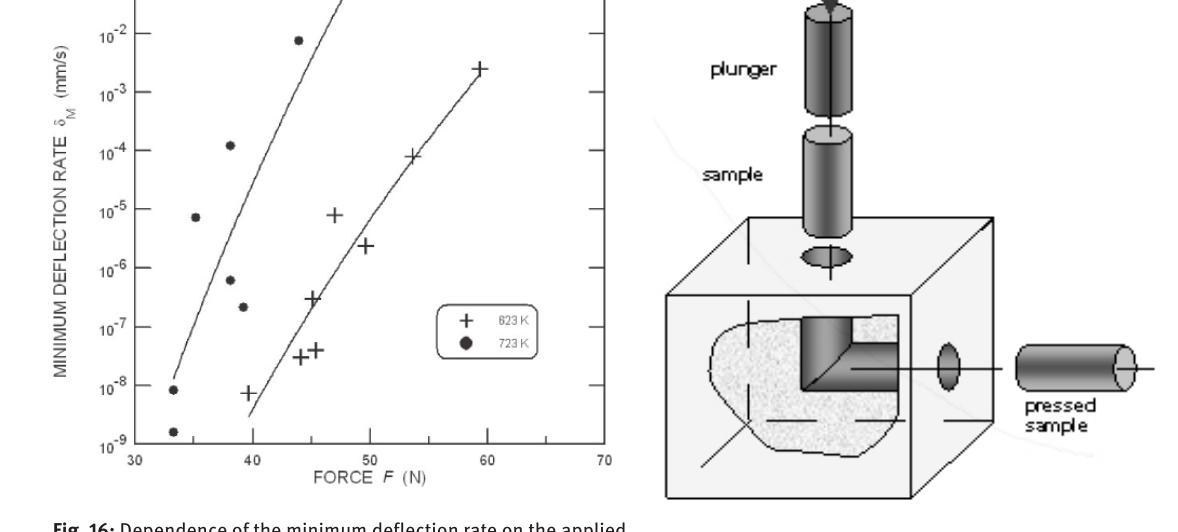
Fig. 18: Scheme of ECAP